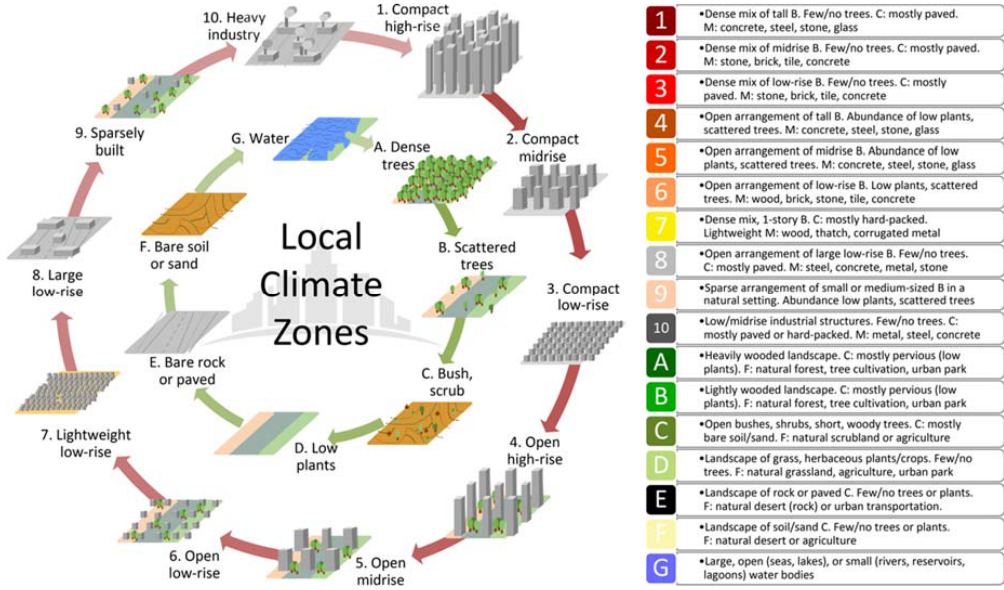
Figure 1. The local climate zone (LCZ) classes with ‘urban ‐ type’ (LCZ1 ‐ 10) and ‘natural type’ (LCZA ‐ G) and the characteristics of each class in urban climate research (from Bechtel et al., 2017 after Stewart and Oke, 2012), © CC ‐ BY